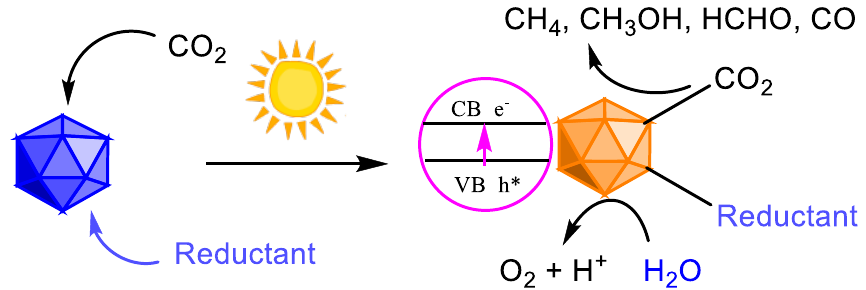
Figure 4. Photoreduction of carbon dioxide on metal oxide catalyst surfaces in the presence of sunlight and water.